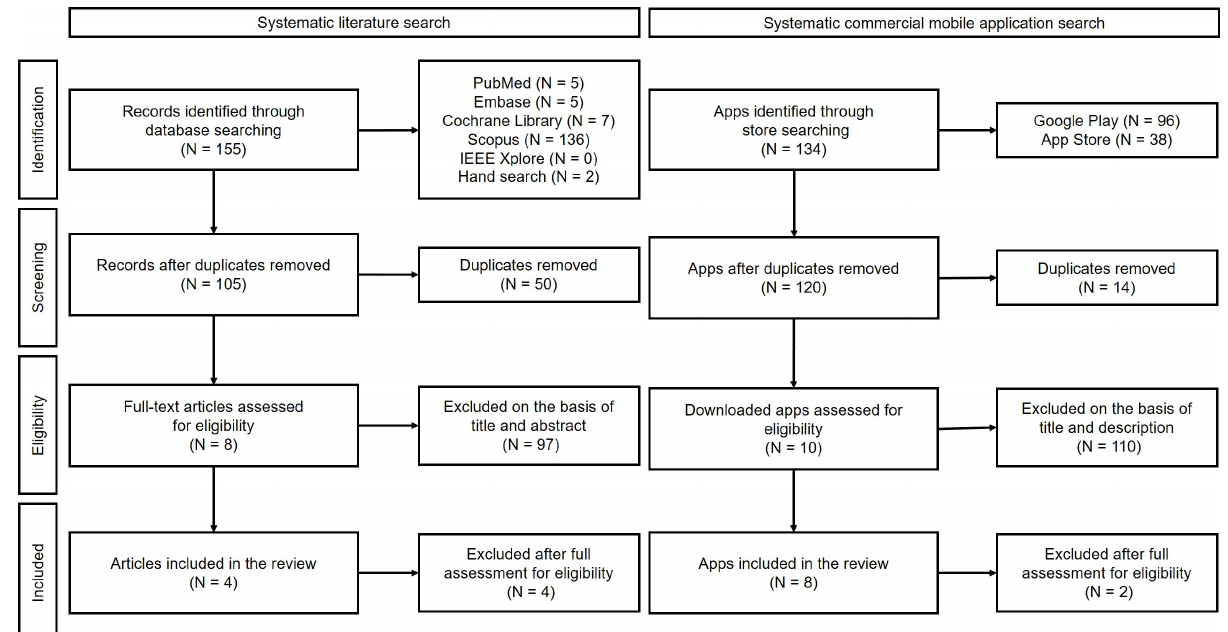
Figure 1. Flowchart of included apps selection processes.